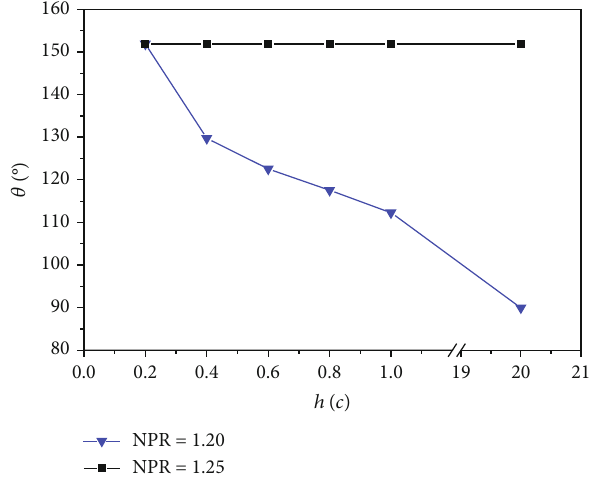
Figure 35: Curves of separation angle versus ride height for the airfoil with upper slot blowing and NPR = 1 : 2 ~ 1 : 25 at α = 8 °